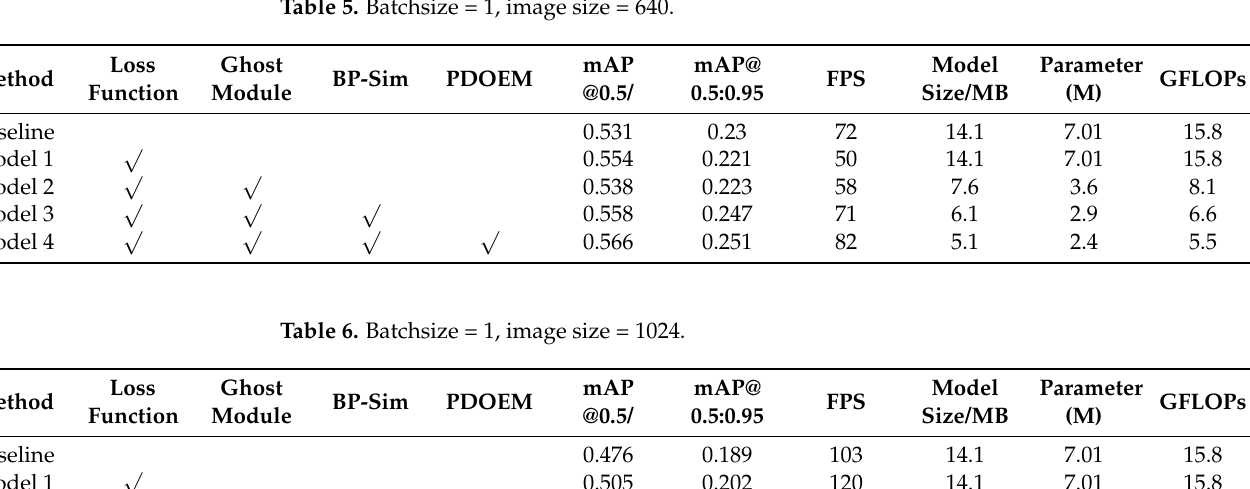
Table 5. Batchsize = 1, image size = 640.